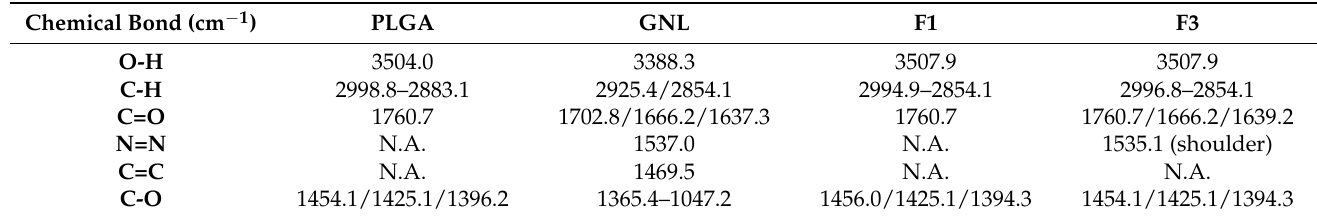
Table 2. Specific chemical bonds for PLGA, GNL, F1, and F3 in IR spectroscopy.